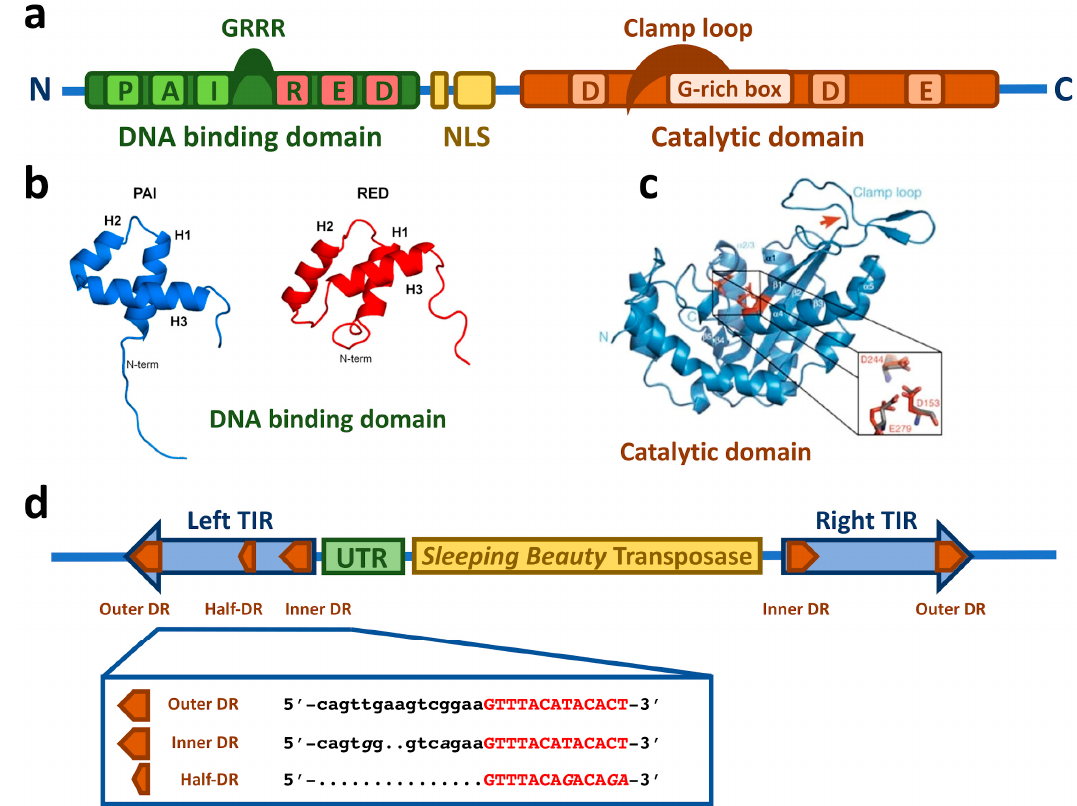
Figure 1. Structural features of the Sleeping Beauty transposable element. ( a ) Schematic drawing of the domain structure of the SB transposase. The SB transposase has an N-terminal bipartite, paired-like DNA binding domain (green box) with the helix-turn-helix PAI subdomain (light green box) and RED subdomain (red box) and a GRRR AT-hook motif. It is followed by a bipartite nuclear localization signal (NLS, yellow boxes) and a C-terminal catalytic domain (orange box), with the DDE amino acid triad catalyzing the DNA cleavage and joining reactions. The clamp loop important for protein–protein interactions is overlapping with a glycine-rich box (light orange box). ( b ) NMR structure of the PAI and RED subdomains of the SB transposase. Reprinted from Protein Science [21] with permission from the publisher. ( c ) Crystal structure of the catalytic domain of the SB transposase with the catalytic triad (DDE) and the clamp loop. Reprinted from Nature Communications [23] with permission from the publisher. ( d ) Schematic drawing of the autonomous SB transposable element with the transposase coding region (yellow box) and the TIRs (blue arrows). An untranslated region (UTR, green box) is situated between the left TIR and the transposase coding region. The TIRs contain two binding sites for the transposase (orange arrows) represented by short directs repeats (DRs), one inner and one outer DR per TIR. In addition, the left TIR contains a “half-DR” sharing sequence similarities with the DRs. The DR core sequence, with which the PAI subdomain of the SB transposase interacts, is typed in